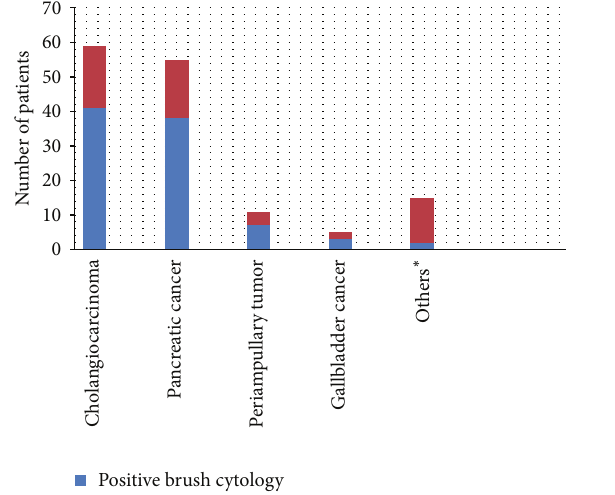
Figure 1: Distribution of the positive biliary brush cytology in ma- lignantstrictures. ∗ Intraductalpapillarymucinousneoplasm,hepat- ocellular carcinoma, and metastasis.